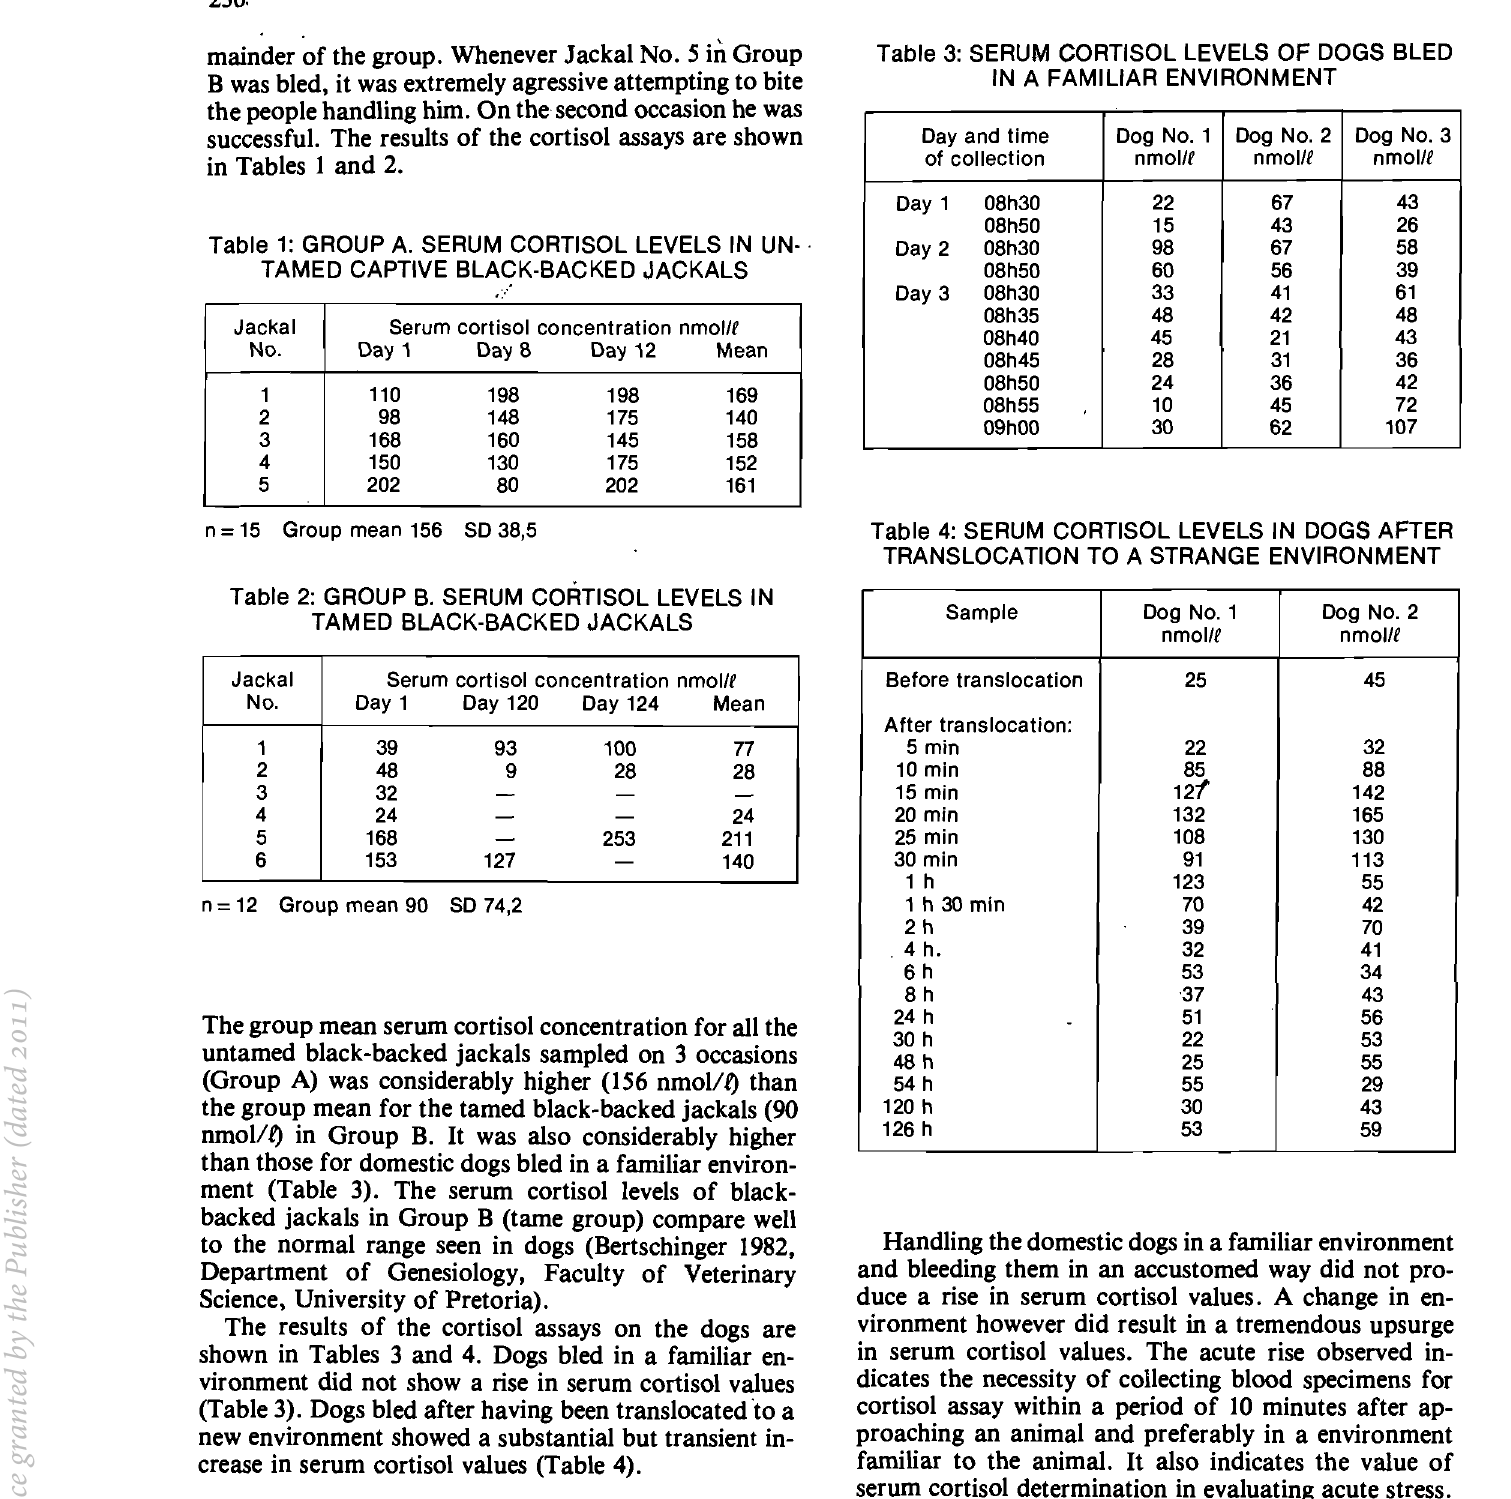
Table 3: SERUM CORTISOL LEVELS OF DOGS BLED IN A FAMILIAR ENVIRONMENT Day and time Dog No.1